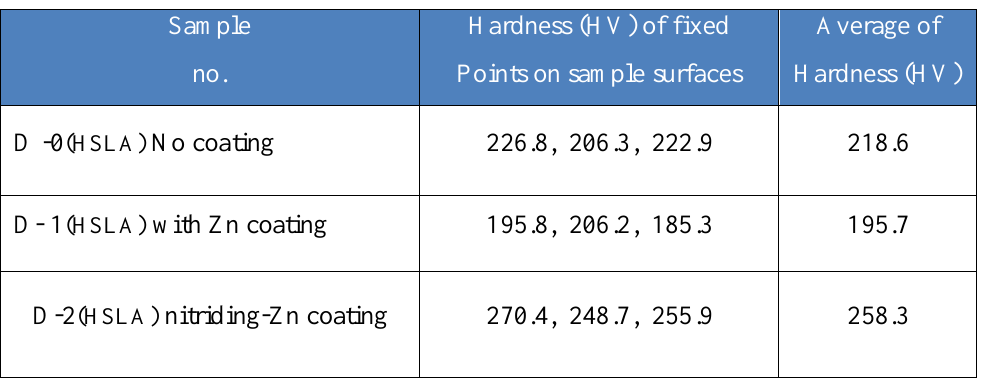
Table 3: The hardness of samples under various